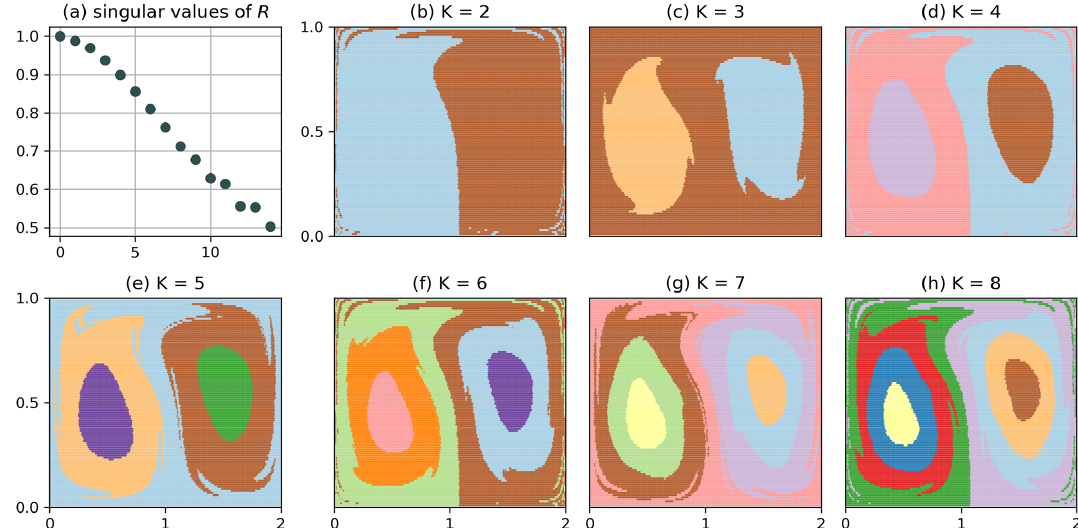
Figure B4. Clustering of Q (simultaneous K -way clustering) for the non-autonomous double gyre with (cid:49)x = (cid:49)y = 0 . 04 and shorter trajec- tories of 10 gyre periods, i.e. τ = 101.